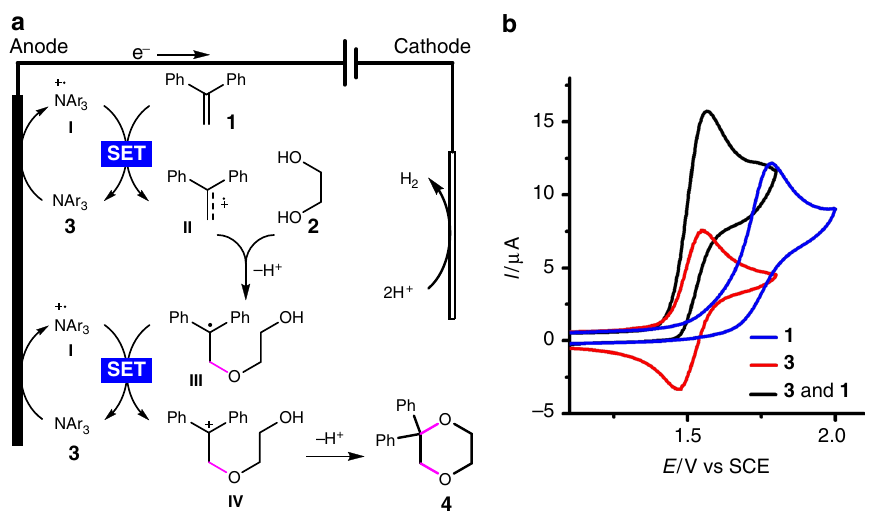
Fig. 3 Mechanistic rationale and cyclic voltammograms. a Mechanistic proposal. b Cyclic voltammograms recorded in MeCN/CH 2 Cl 2 (6:1) with 0.1 M Et 4 NPF 6 as the supporting electrolyte. 3 (2.6 mM). 1 (1.3 mM). SET, single-electron transfer